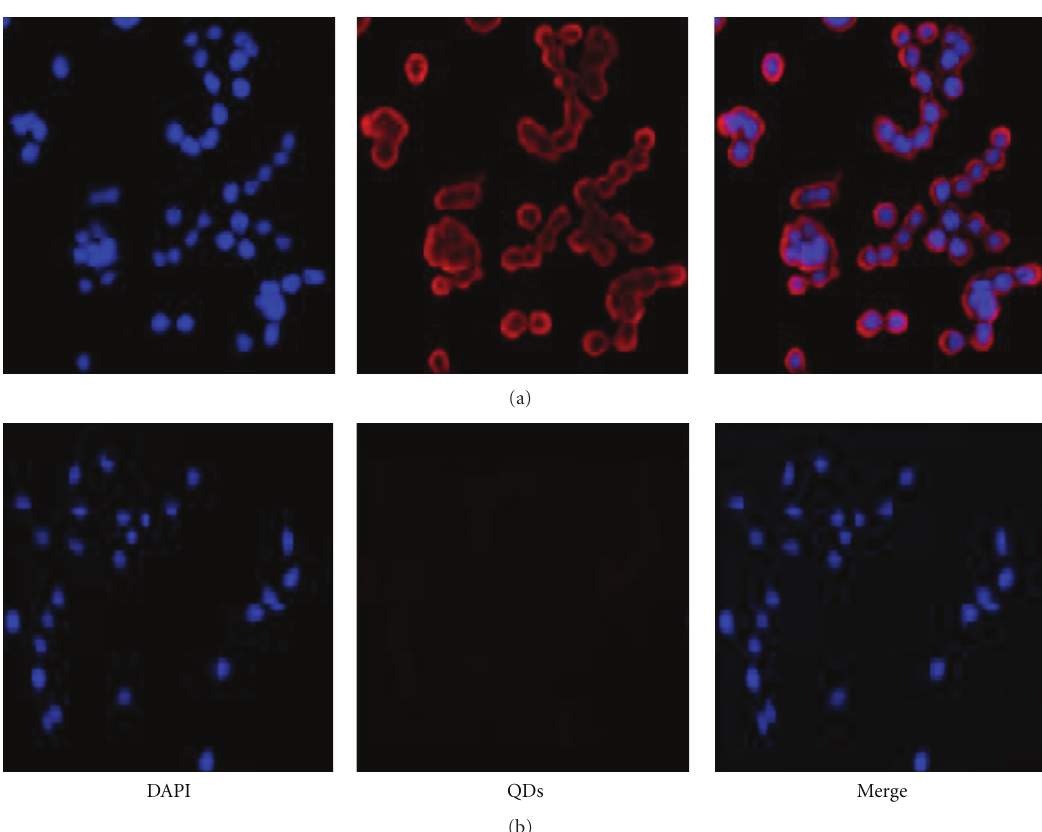
Figure 1: Immunofluroscent staining of HT29 cells for Tn antigen expression. (a) HT29 cells stained with AQD-Tn mAb complexes; (b) negative control, PEG activated AQD without antibody. Blue: nuclei, red: Tn antigen expression.